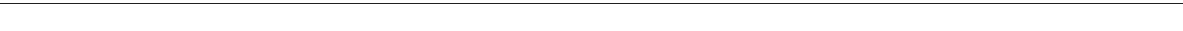
Fig. 5 PP2A-B55 α holoenzymes dephosphorylate SAMHD1 at T592 in vitro and in cells. a – c PP2A-B55 α holoenzymes dephosphorylate SAMHD1 at pT592 in vitro. GFP-trapped active PP2A trimer complexes or GFP only were retrieved from HEK293T cells. After incubation with recombinant SAMHD1 for the indicated time points, samples were assessed by immunoblotting using antibodies speci fi c to the indicated proteins. a Before incubation with recombinant SAMHD1, undiluted (1/1) and 1/3 diluted beads were either pre-incubated with buffer or 50 nM okadaic acid (OA) for 10 min at 30 °C. Data are representative of two independent experiments. b Puri fi ed PP2A D was added as an additional condition. Anti-PP2A C immunoblots allow to directly compare the amount of C subunit in both PP2A complexes (PP2A-B55 α trimer versus PP2A D ). The lanes shown are derived from the same blot, but were not adjacently loaded. Data are representative of two independent experiments. c Anti-C immunoblotting indicates the amount of retrieved PP2A C subunit in these complexes. Data are representative of two independent experiments. d , e Inhibition of PP2A by OA ( d ) or siRNA-mediated silencing ( e ) increases SAMHD1 phosphorylation at T592 in cycling HeLa cells. d HeLa cells were treated with the phosphatase inhibitor OA (2 nM), harvested at different time points and analyzed by immunoblotting. e HeLa cells were transfected with control siRNA (lane 1), simultaneously with three different siRNAs targeting all subunits of the PP2A-B55 α trimer (lane 3) or with single siRNAs targeting individual PP2A subunits (lane 4 – 6). 52 h post-transfection, cells were harvested and analyzed by immunoblotting. Data shown are representative of three ( d ) or two ( e ) independent experiments, respectively. f , g Inhibition of PP2A by OA ( f ) or by siRNA-mediated silencing of PP2A B55 α subunit ( g ) increases SAMHD1 phosphorylation at T592 in MDMs. f MDMs were treated with the phosphatase inhibitor OA (2 nM), harvested at different time points and analyzed by immunoblotting. Data shown represent three donors analyzed. g MDMs were transfected with control siRNA or siRNA targeting B55 α . 48 h post-transfection, cells were harvested and whole-cell lysates were analyzed by immunoblotting ( g , left panel). For quanti fi cation, the signal of PP2A B55 α subunit was normalized to GAPDH and compared to the control ( g , left panel). In parallel, RNA samples were collected and PPP2R2A (B55 α ) mRNA levels determined by RT-qPCR ( g , right panel). Data were normalized to the reference gene RPL13A . Fold change of PPP2R2A (B55 α ) mRNA level to siCtr was calculated based on three technical replicates; the graph shows the mean ± SD of the technical replicates (right panel). Data shown represent one of three donors analyzed